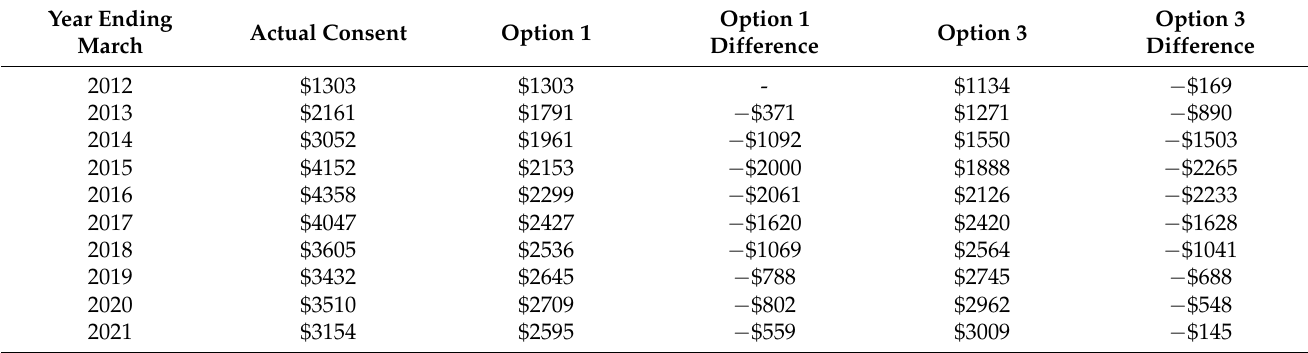
Table 1. Estimated value of the rebuild activity, year-end March value (NZD,